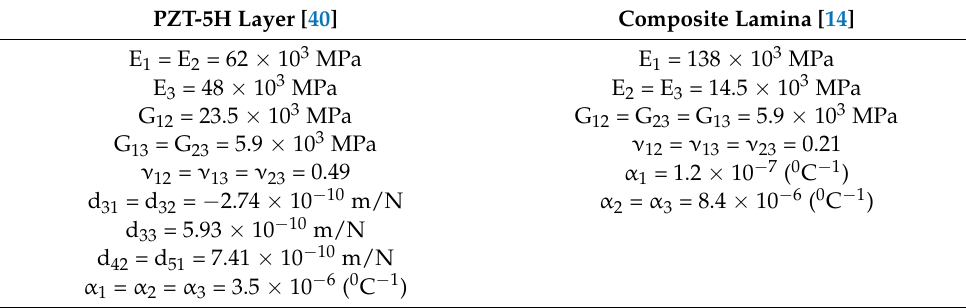
Table 1. Material properties of the PZT-5H layer and composite lamina. PZT-5H Layer [40] Composite Lamina